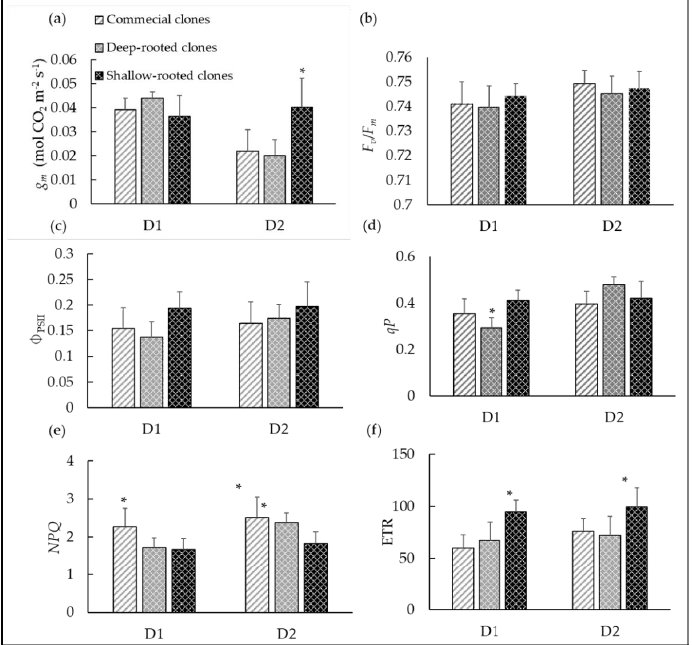
Figure 4. Changes in chlorophyll fluorescence parameters in dry-farmed and commercial clones at the peak of 1st and 2nd drought cycles. ( a ) Mesophyll conductance ( g m ), ( b ) maximum photochemical efficiency ( F v / F m ), ( c ) actual photochemical efficiency (Φ PSII ), ( d ) photochemical quenching coafficient ( qP ), ( e ) non-photochemical quenching (NPQ), and ( f ) electron transport rate (ETR). Values are means ± SEM of six biological replicates. Statistical analysis was conducted using two-way ANOVA. Asterisks indicate statistically significant differences ( p < 0.05) between clones within each drought cycle.